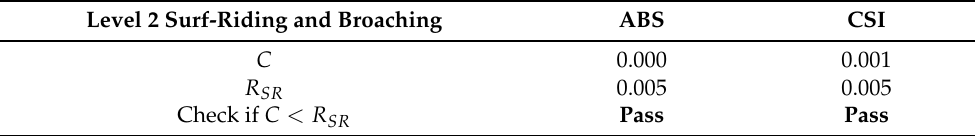
Table 35. Level 2 assessment of surf-riding and broaching failure mode for the KCS container